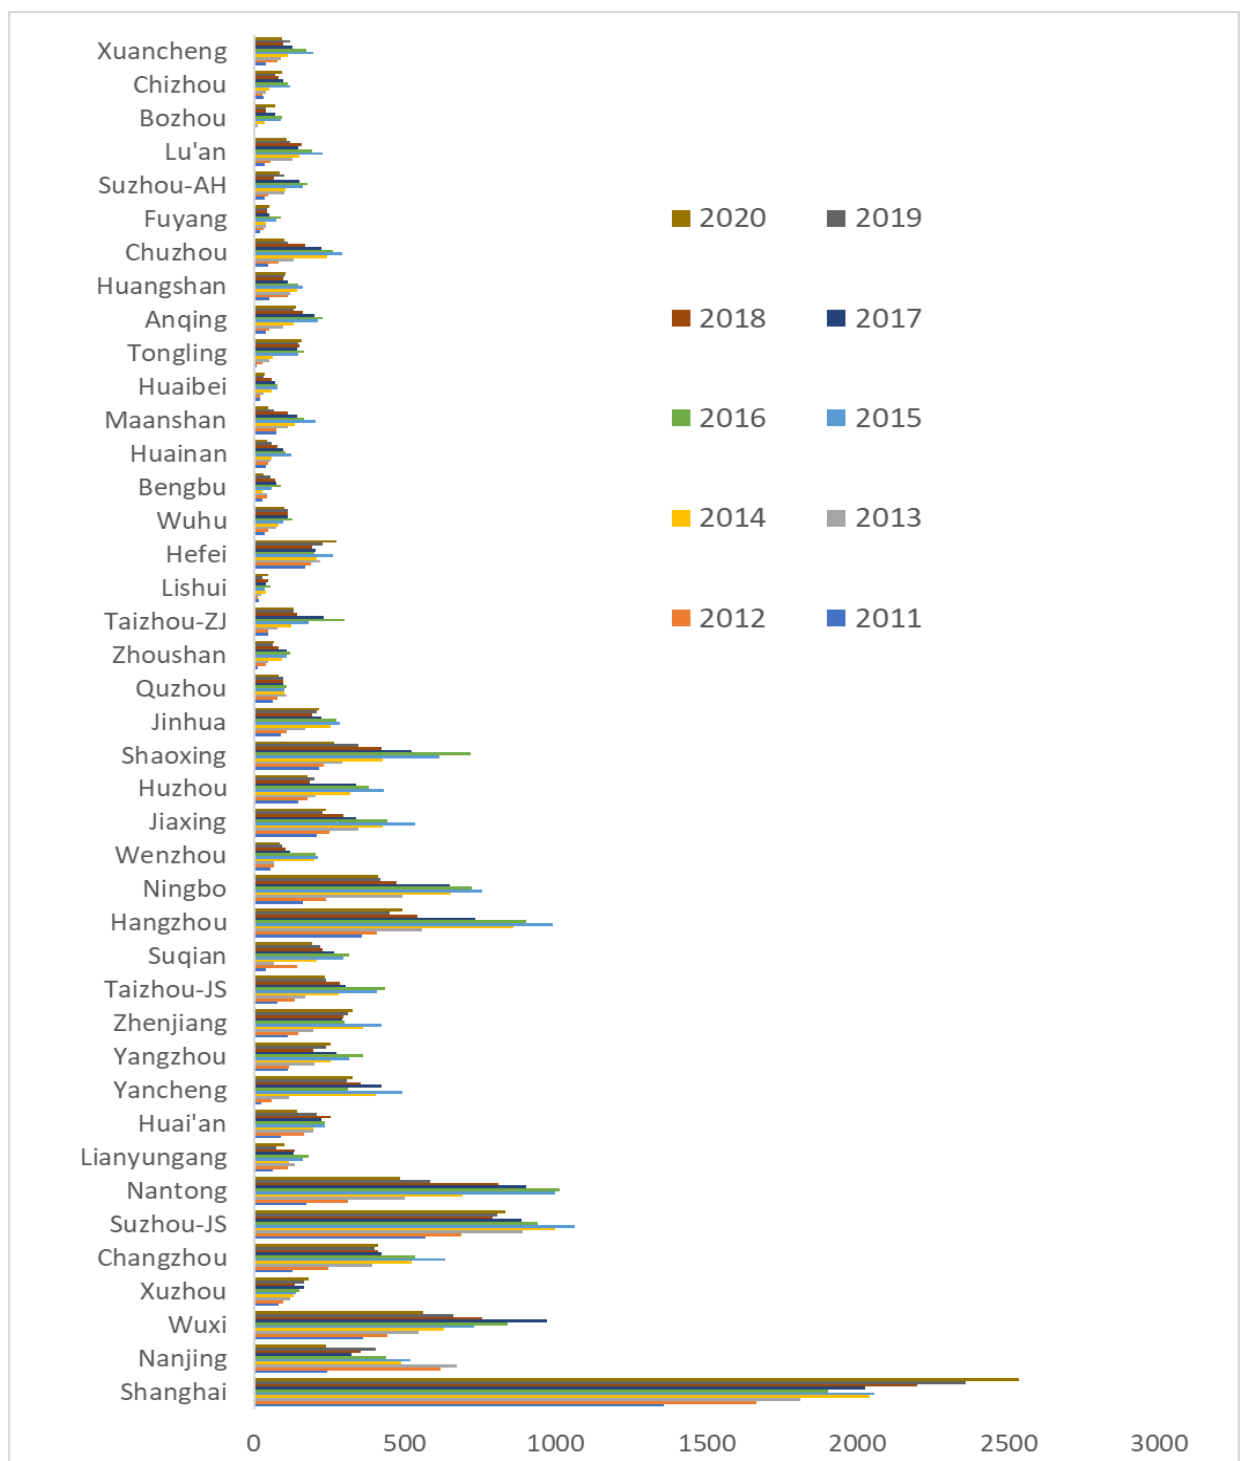
Figure 3. Analysis on the change of real estate inventory in the Yangtze River Delta. Real estate inventories in most Yangtze River Delta cities remained rapid positive- growth from 2011 to 2020, with all cities in a state of high positive-growth from 2011 to 2015 and most cities in a state of negative growth from 2016 to 2020. The average real